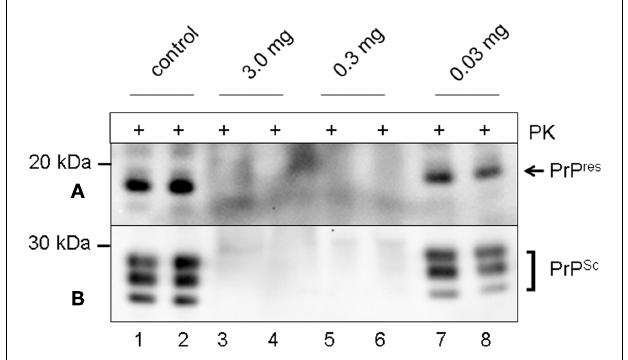
FIGURE 2 |Western blot analysis of inhibition of PrP res formation and disaggregation of pre-existing PrP Sc fibrils in a cell-free conversion assay. (A) Tea of S. lateriflora inhibits formation of PrP res . Lanes 1–2 show PK-resistant PrP res -fragments in samples without tea, lanes 3–4 samples after co-incubation with 3.0mg dried tea extract, lanes 5–6 with 0.3mg dried tea extract, and lanes 7–8 co-incubation with 0.03mg dried tea extract. Detection was carried out with mab P4. (B) Tea of S. lateriflora disaggregates pre-existing fibrils after digestion with PK.The membrane